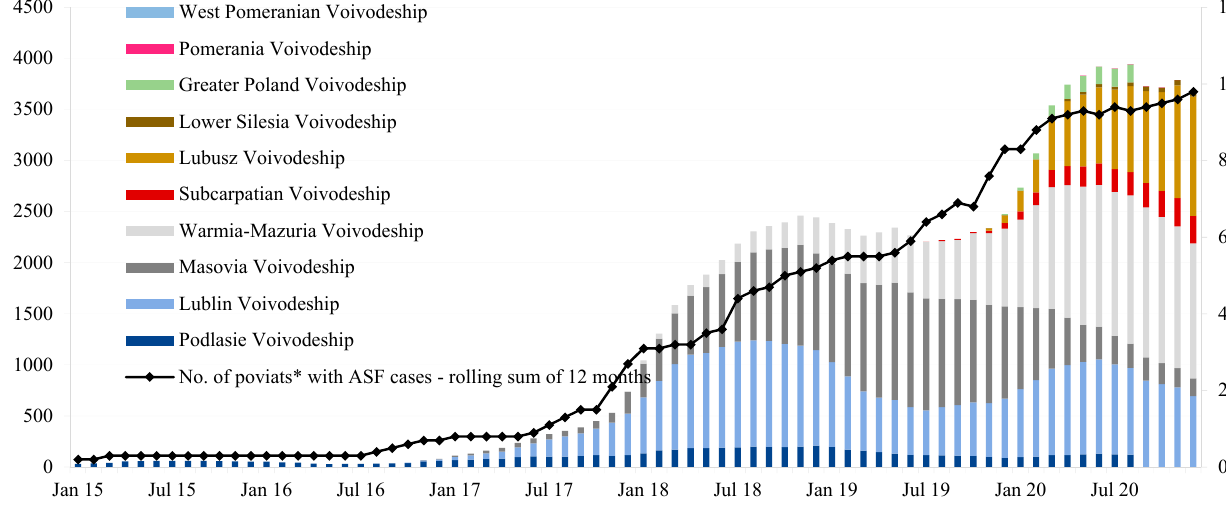
Figure 2. Cumulative number of ASF cases in voivodeships in 2015–2020. Source: own study based on CVI and PKO BP data.